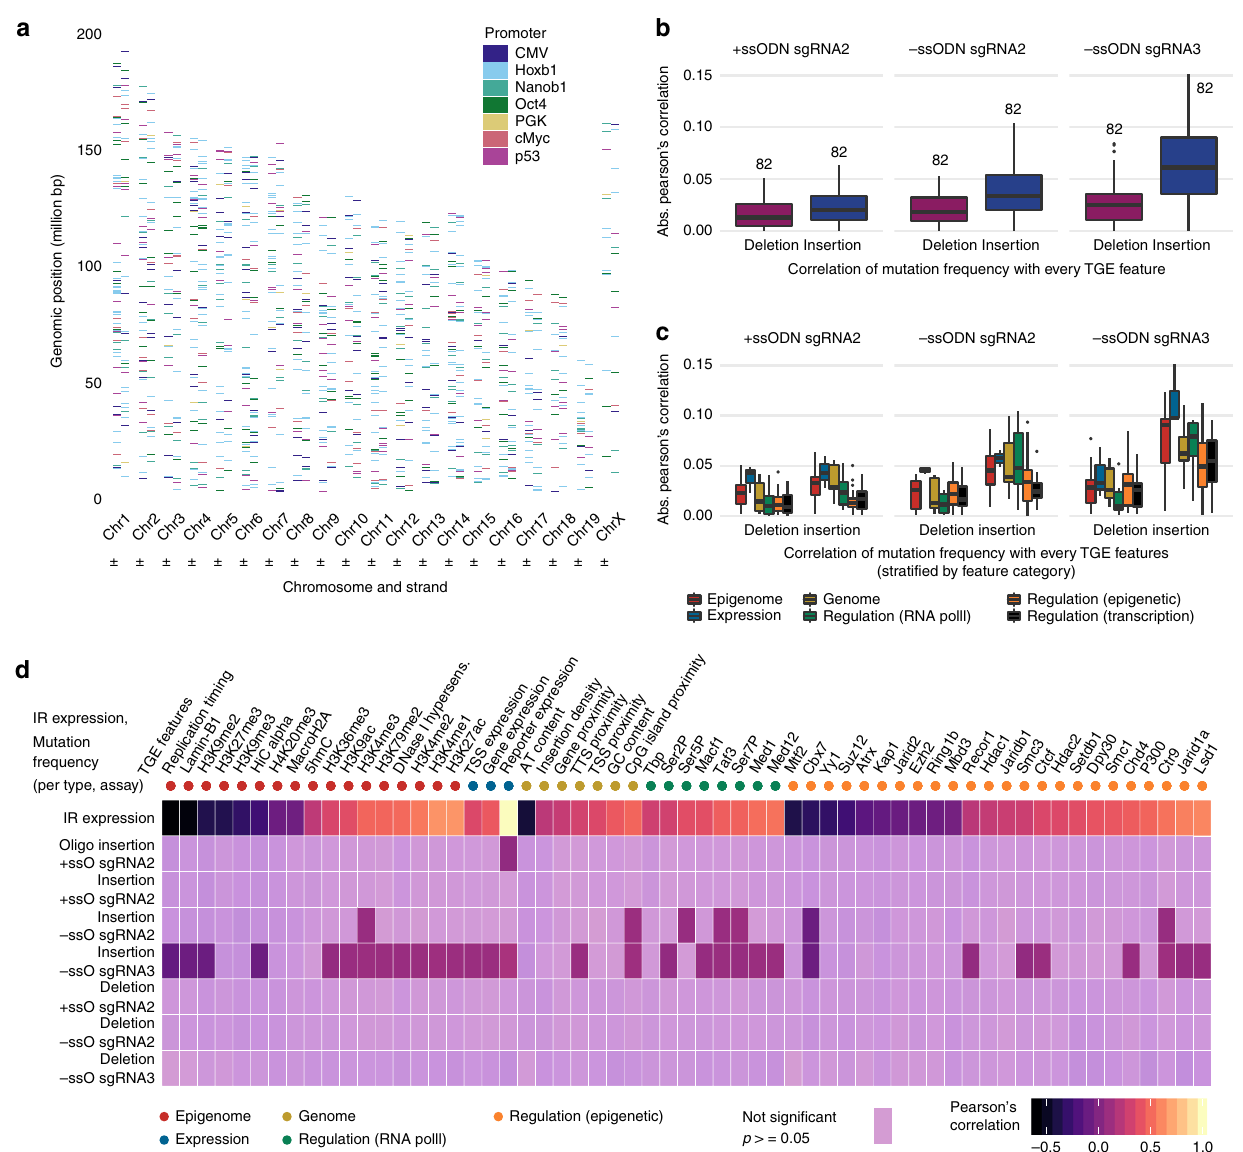
Fig. 3 Correlation of TGE features with Cas9-induced IR mutation frequency in the TRIP pool. a Genomic location of the 1359 IRs with at least 30 mapped reads in all TRIP pool Cas9 assays. Each tick denotes the location of an IR on the chromosome, colored according to the associated promoter. b Correlation of TGE features with IR mutation frequency per guide RNA. Boxplots show the distribution of absolute Pearson ’ s correlations between deletion (red) or insertion (blue) frequency and each of 82 distinct TGE features across IRs. Boxes show the median, fi rst and third quartiles of the frequency distributions; whiskers extend to 1.5 times the inter-quartile range from the top and bottom of the box. c Correlation of IR mutation frequency with TGE features strati fi ed per category. Boxplots show the distribution of absolute Pearson ’ s correlations between deletion or insertion frequency and each of 82 TGE features strati fi ed into six categories (color-coded according to legend). d Correlation between IR expression or IR mutation frequency and TGE features. Heatmap shows the Pearson ’ s correlation between IR expression or IR mutation frequency (deletion or insertion) in the different TRIP pool assays (rows), and individual TGE features from a subset of 62 (columns), including all except transcriptional regulators without known epigenetic activity. Cells are gradient- colored based on correlation values, and color intensity denotes signi fi cance of adjusted p-value. Colored circles at the top indicate TGE feature categories. Source data are provided in the Source Data fi le 0.021 ± 0.007, p ≈ 1.91 × 10 − 9 , two-tailed Wilcoxon signed rank gene proximity in mES cells 28 . Epigenomic features included chromatin density from Hi-C assays, and chromatin immuno- test sgRNA2 ± ssODN and sgRNA3-ssODN insertions vs. precipitation (ChIP) data for numerous histone modi fi cations, sgRNA2 ± ssODN and sgRNA3-ssODN deletions). Correlations DNaseI hypersensitivity, and Lamin-B1 in mES cells 28 . were also higher for sgRNA3 compared with sgRNA2, more so We quanti fi ed TGE features within a region of 2 kb surround- for insertions than deletions (effect size 0.022 ± 0.008, p ≈ 2.67 × ing each IR locus and calculated their correlation with IR 10 − 7 for insertions, 0.016 ± 0.009, p ≈ 0.0001 for deletions, two- tailed Wilcoxon signed rank test sgRNA3-ssODN vs. sgRNA2- mutation frequency. Mutation frequency correlated weakly with ssODN). We investigated whether changes induced by TRIP IRs TGE features (Pearson ’ s r = [ − 0.123, 0.151], (Fig. 3b – d)), but could have disrupted the correlation between IR mutation insertions showed stronger association than deletions (effect size NATURE COMMUNICATIONS| (2019) 10:1598